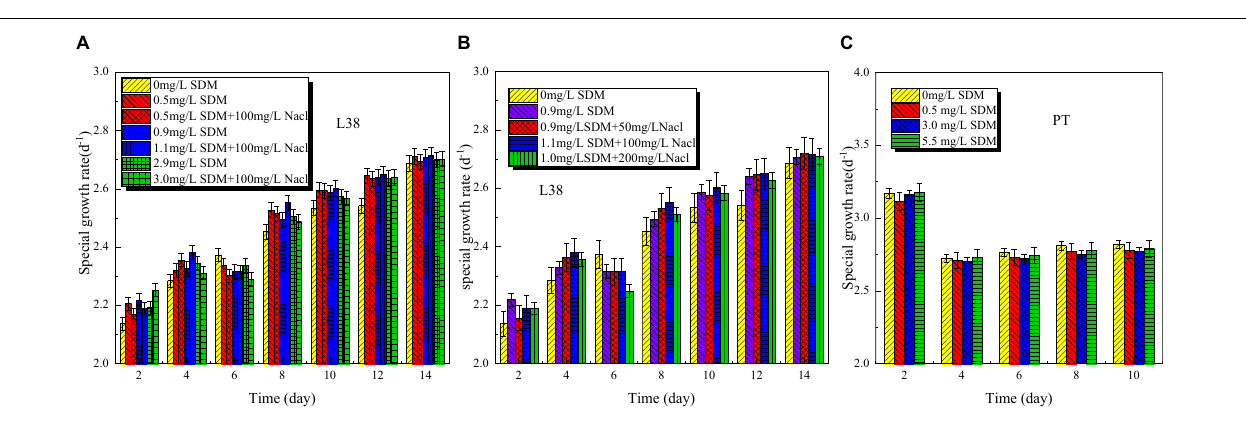
FIGURE 1 | Optical density (OD) variation of Chlorella sp. L38 (A,B) and Phaeodactylum tricornutum MASCC-0025 (C) under different sulfadimethoxine (SDM) concentrations.